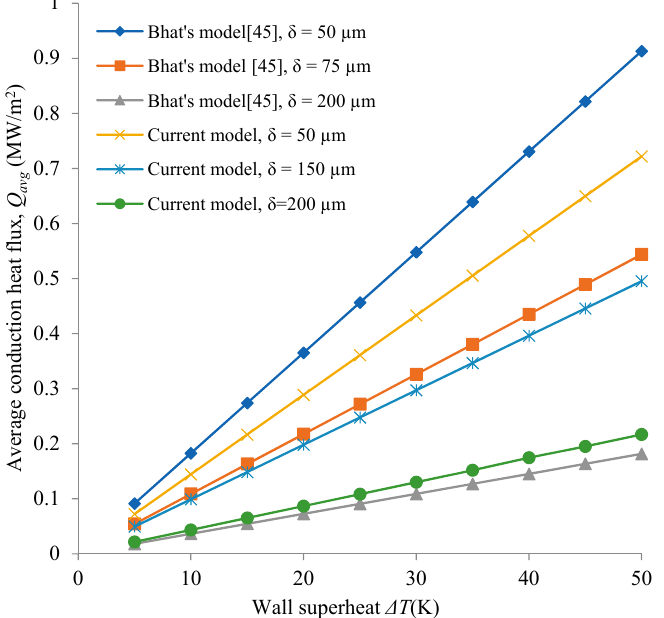
Figure 3. Dependence of average heat fluxes on wall superheat ( t c = 40 ms, 1/F = 40